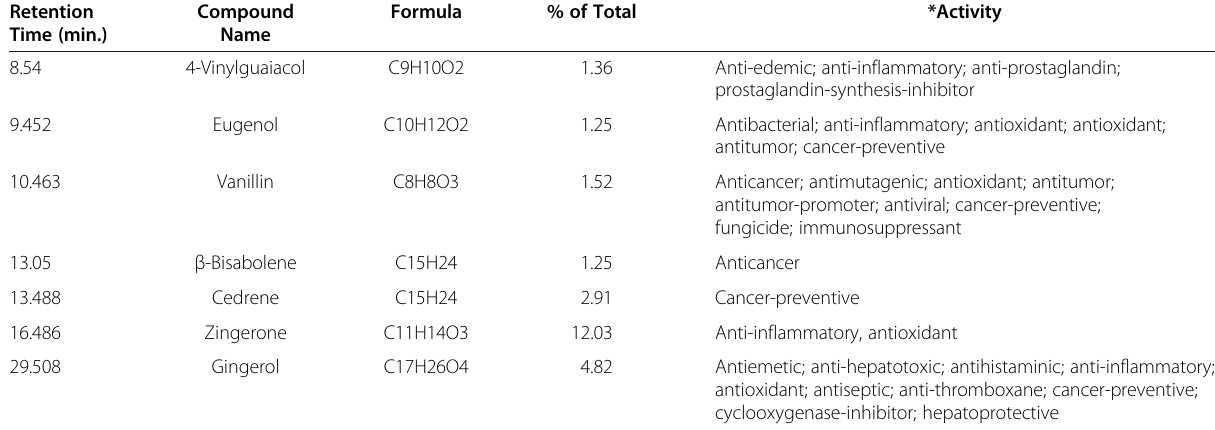
Table 1 Anticancer compounds of 50% ethanolic extract of fenugreek seeds identified by GC-MS Retention Time